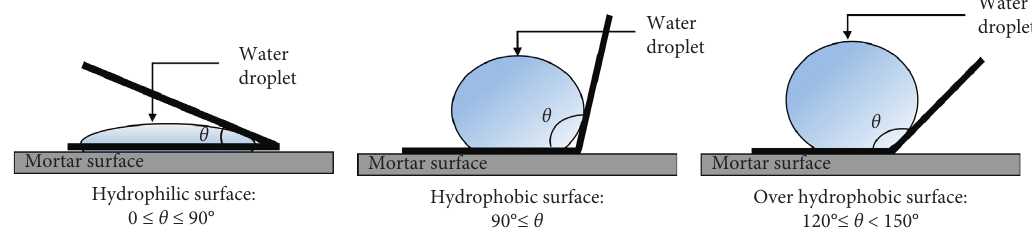
Figure 10: Range of water contact angle for hydrophilic, hydrophobic, and over hydrophobic surfaces